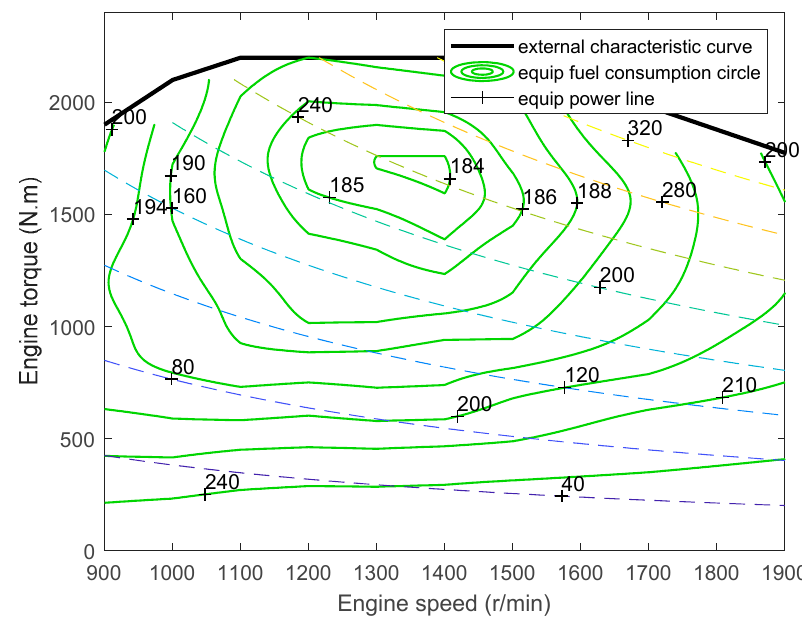
Figure 2. The engine fuel consumption characteristics map of the heavy-duty mining truck.